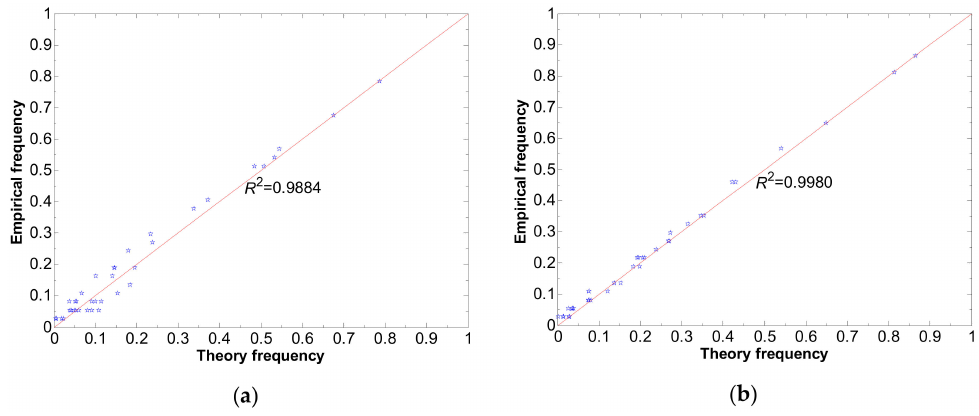
Figure 4. Q-Q (Quantile-Quantile) plots of two-dimensional (2D) Empirical Copula Functions and 3D plots of the Frank Copula Function. ( a ) Q-Q plots of the joint distribution function of the marginal distribution of the buried depth and surface water irrigation volume; and, ( b ) Q-Q plots of the joint distribution function of the marginal distribution of the buried depth and